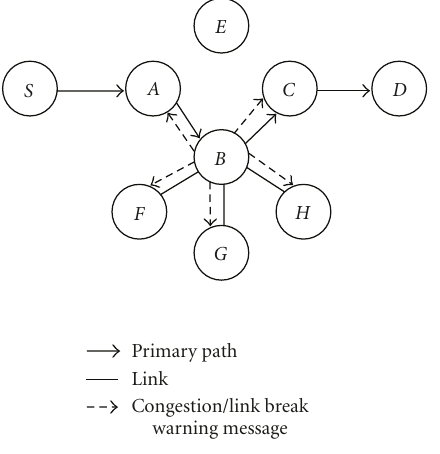
Figure 5: Congestion/Link break warning message.